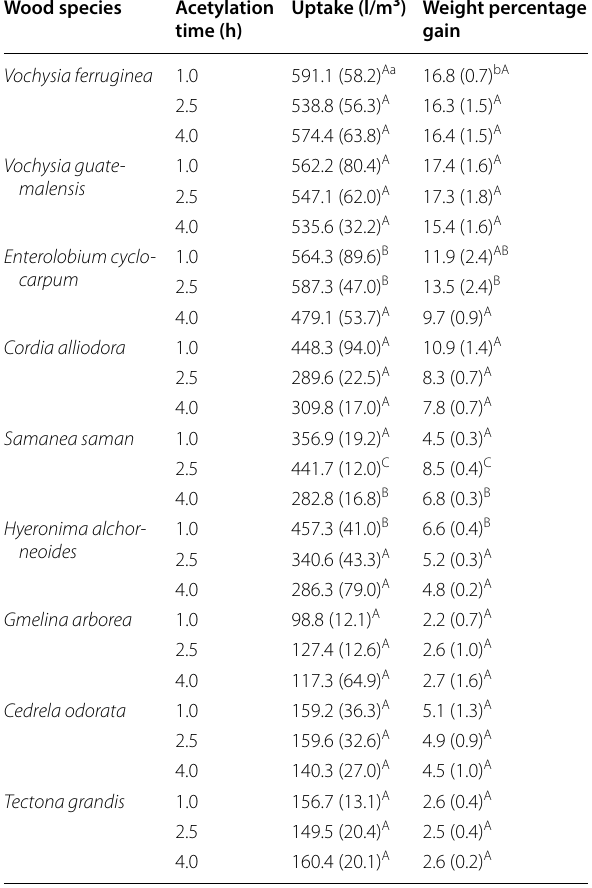
Table 1 Uptake and weight percentage gain of wood from nine tropical woods treated with acetic anhydride at three different acetylation